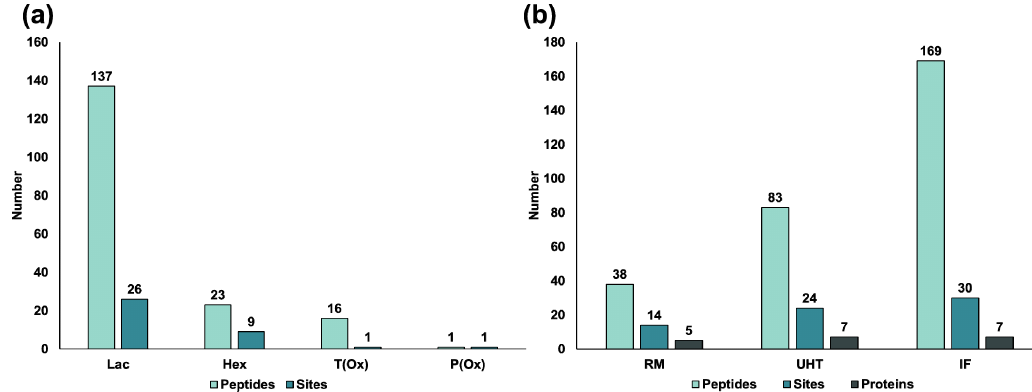
Figure 3. ( a ) Numbers of modified peptides identified with at least one lactosylation (Lac), hexosylation (Hex), and oxidation site in all milk samples (T(Ox) and P(Ox); ( b ) Number of modified peptides, modification sites, and corresponding proteins identified in RM, UHT milk, and